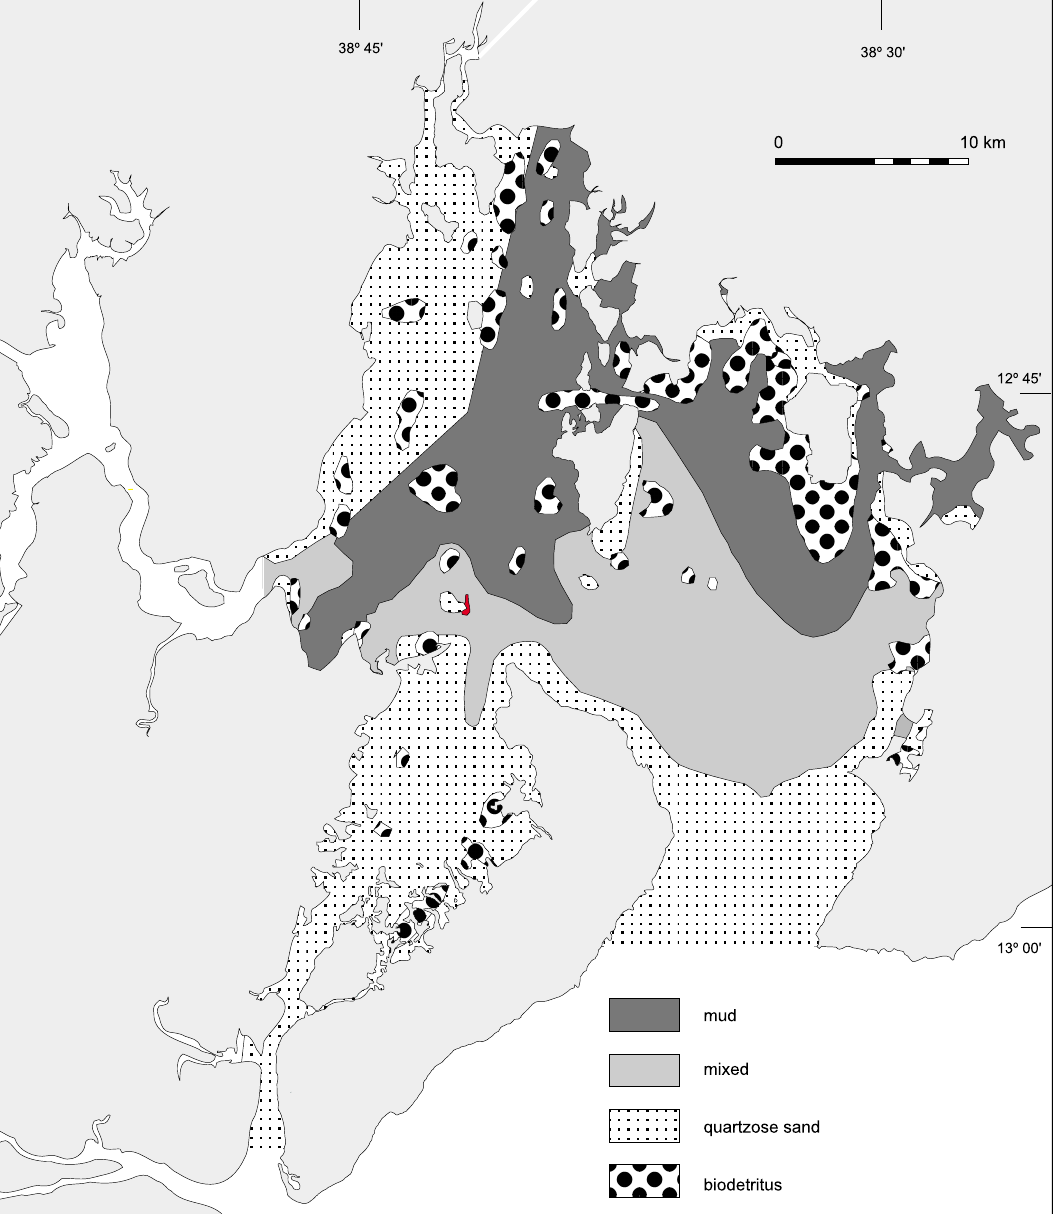
Fig. 6 – Surface sedimentary facies inside the TSB (after Bittencourt et al.